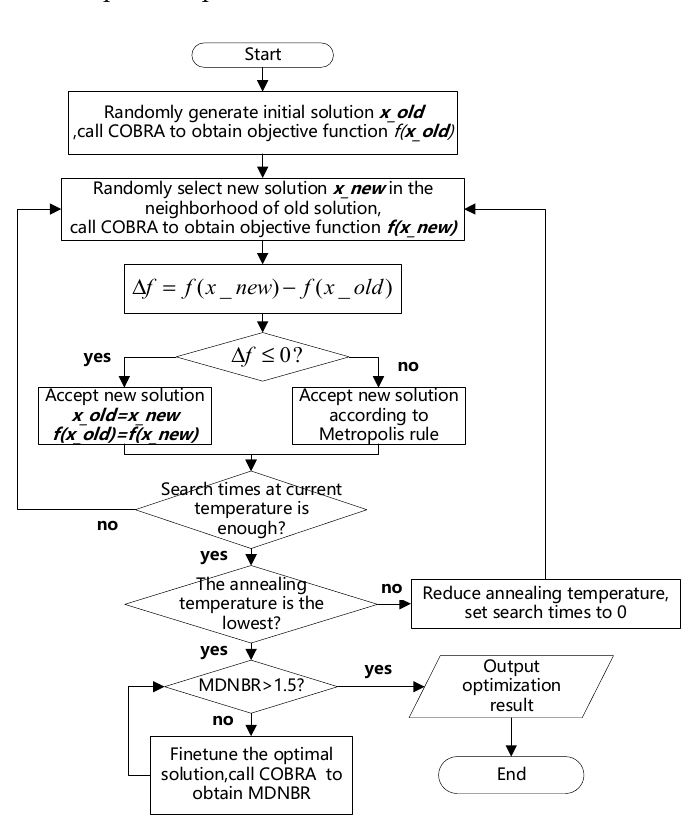
Figure 2. Flow chart of optimization code based on SA.